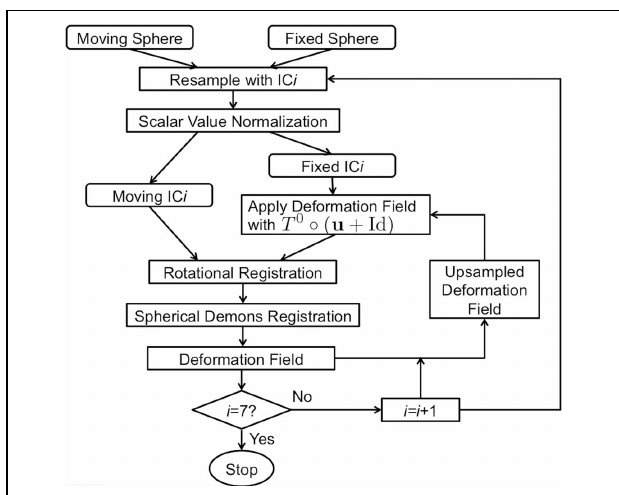
FIGURE 2 | The flowchart of the surface registration used to align surfaces for parcellation. The inputs are spheres with geometry features and the output is the deformation field defined as vectors at vertices on the fixed sphere.